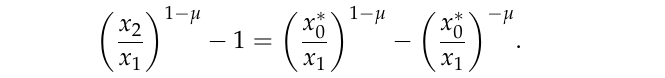
as a function of µ . The position of 0